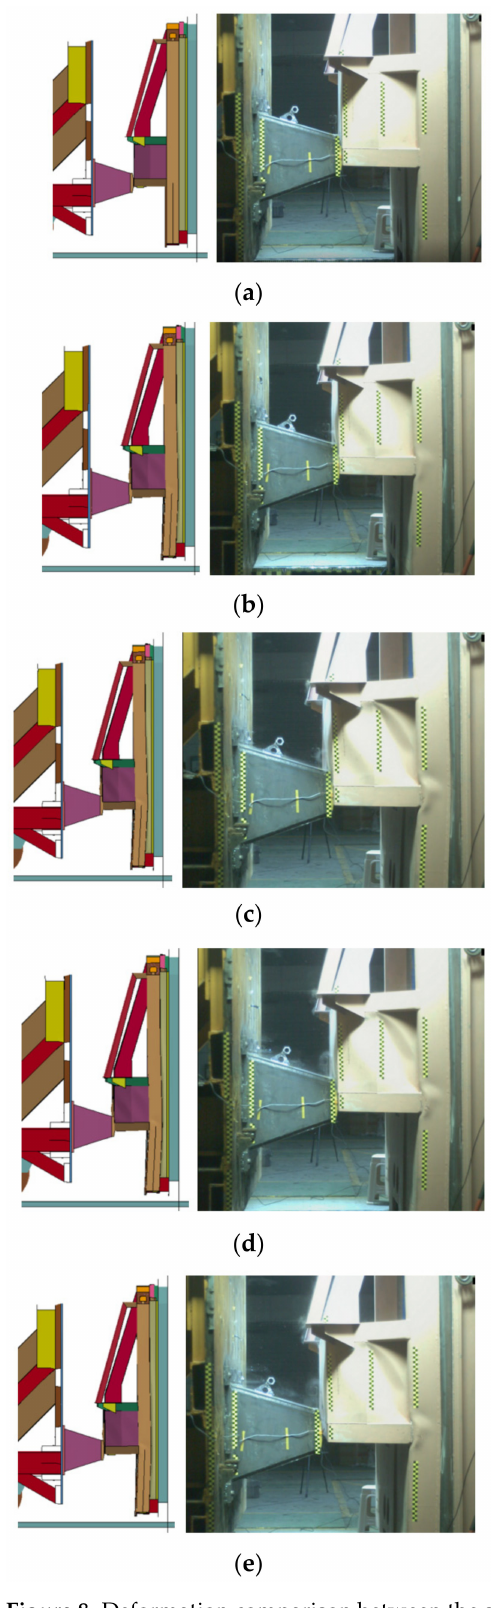
Figure 8. Deformation comparison between the simulation and experiment: ( a ) t = 0, simulation: 0, experiment: 0; ( b ) t = 16 ms, simulation: 47.8 mm, experiment: 49.142 mm; ( c ) t = 25 ms, simulation: 55.1 mm, experiment: 59.317 mm; ( d ) t = 33 ms, simulation: 48 mm, experiment: 50.488 mm; ( e ) t = 49 ms, simulation: 33.6 mm, experiment: 31.577